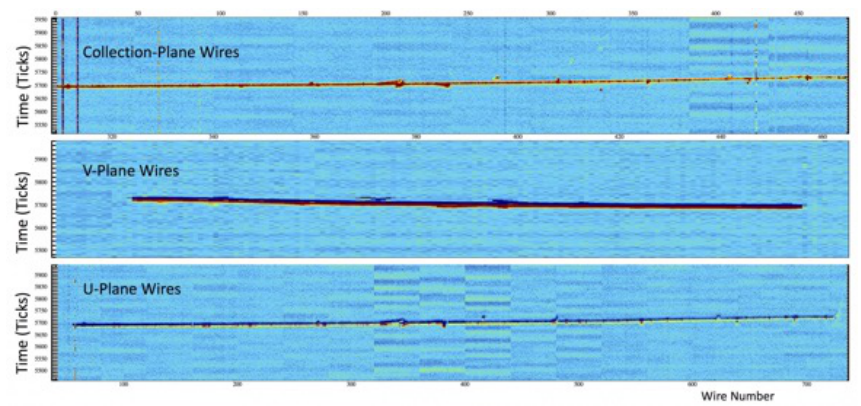
Figure 3: One of the first cosmic muon particle tracks, with about 3.8 m length, observed by the ProtoDUNE detector at CERN. The signal is recorded on three wire planes. From Ref. [ 8 ]